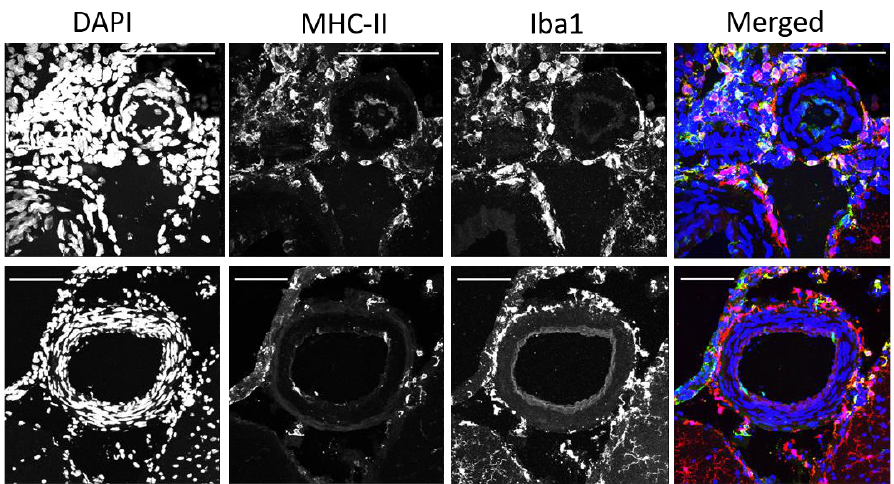
Figure 4. Representative images from a Dahl-SS/Jr prior pregnant female showing MHC-II staining in PVAMs. Some PVAM were double positive for Iba1 and MHC-II. Upper Panel: Pial arteriole sur- rounded by Iba1+/MHC-II+ PVAM. Lower Panel: Pial vessel with PVAMs of varying distances sur- rounding it with associated arachnoid layer at the cortical surface. Red = Iba1. Green = MHC-II. Blue = DAPI. Scale bar = 100 µm.